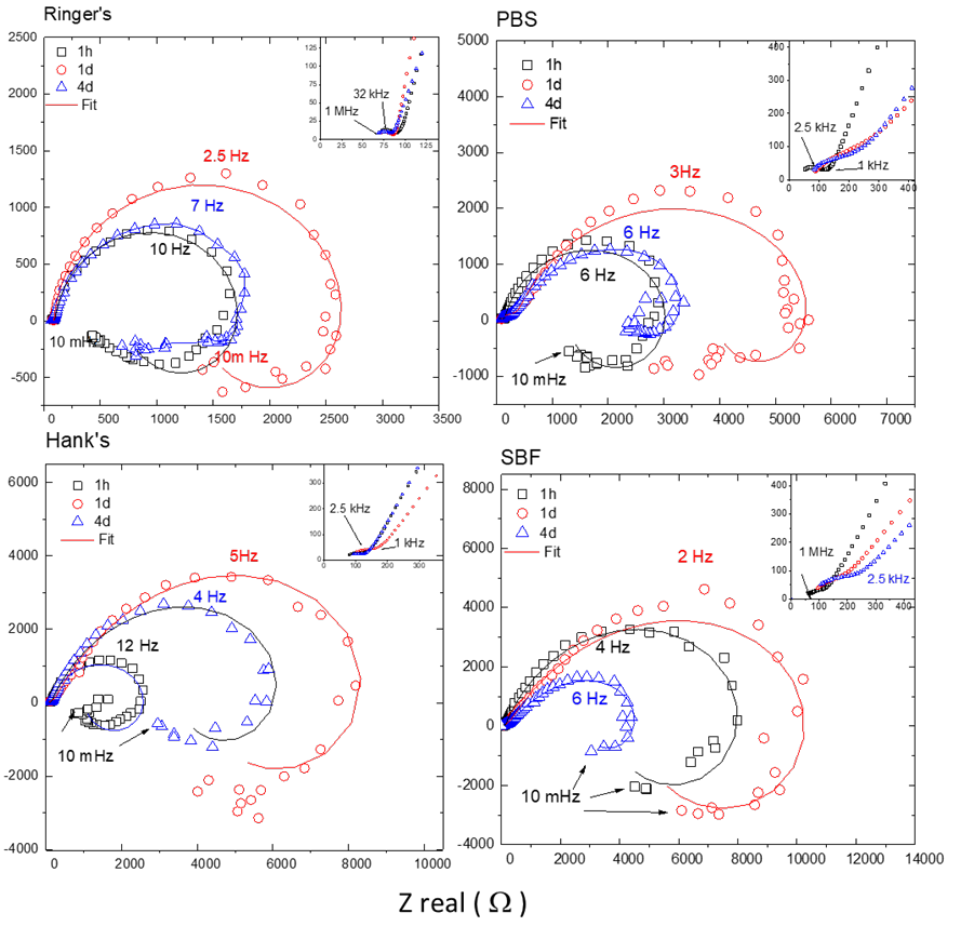
Figure 6. Typical Nyquist plots with respective fitting for AZ31B specimens after 1 h, 1 d, and 4 d of immersion at the open circuit potential (OCP) in ( a ) Ringer’s, ( b ) PBS, ( c ) Hank’s, and ( d ) SBF solutions. Samples had an exposed area of 0.78 cm 2 . Fitting results shown in Table